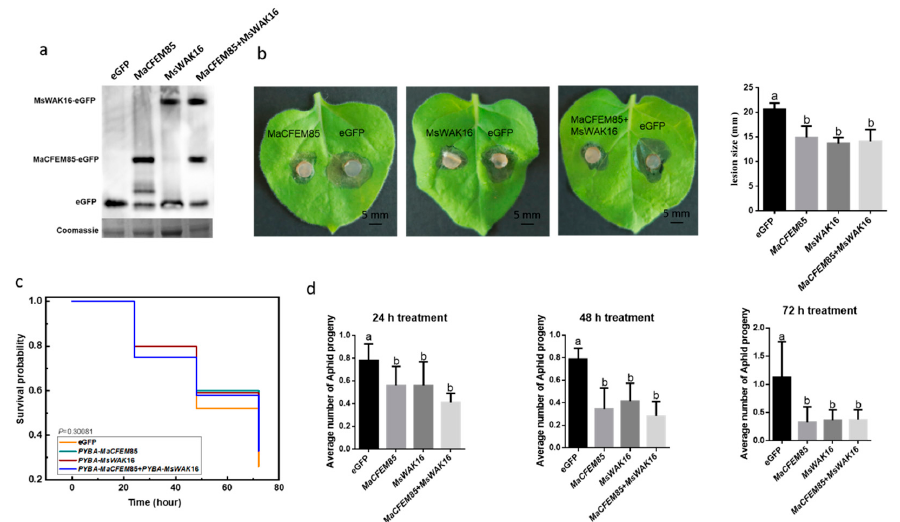
Figure 4. Induction of plant resistance by transient expression of MaCFEM85 and MsWAK16. ( a ) Transient expression of MaCFEM85, MsWAK16, or MaCFEM85+MsWAK16 in N. benthamiana leaves. Protein expression level of MaCFEM85 and MsWAK16. Leaf samples were harvested 12 h after infiltration and total soluble protein extracts were prepared. Proteins were separated by SDS– PAGE and analyzed via immunoblot using a GFP-specific antibody. Total protein content (showing equal loading) was measured with Coomassie staining. ( b ) N. benthamiana leaf lesions resulting from B. cinerea infection. Lesion sizes were measured at 2 d after inoculation in a minimum of nine leaves for each treatment group. Data presented in ( b ) is the mean ± standard error, and Letters indicate statistical significance between groups at p < 0.05 . ( c ) The mortality risk of aphids feeding on N. benthamiana transiently expressing MaCFEM85, MsWAK16, or MaCFEM85+MsWAK16 . ( d ) The average number of progeny from each aphid after feeding on tobacco transiently expressing GFP, MaCFEM85, MsWAK16, or MaCFEM85+MsWAK16 for 24, 48, and 72 h, respectively. Values are shown as the mean ± standard error ( n = 20).